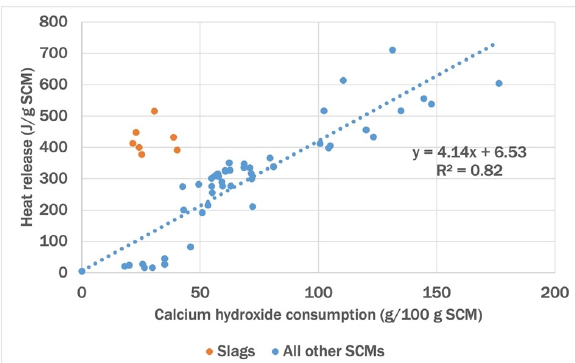
Figure 3. Heat release plotted against calcium hydroxide consumption for several SCMs of different types using the modified R 3 test (adapted using data from [9]).